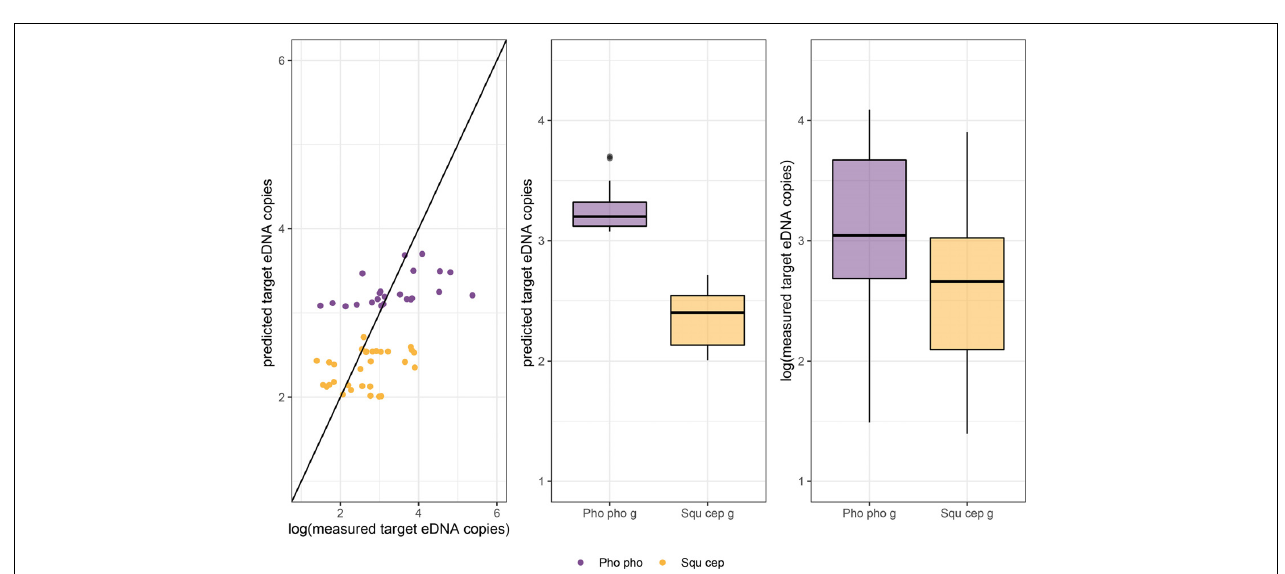
FIGURE 6 | For groups of Phoxinus phoxinus (Pho pho g) and Squalius cephalus (Squ cep g) measured and predicted copy numbers are plotted: left, against each other; middle, predicted copy numbers are compared between species; right, comparison of measured copy numbers between the two species. The measured copy numbers were log-transformed to enable a direct comparison with the values predicted by the Gamma GLMM with log-link function; the random effect of individual fish could not be taken into account for this prediction. For S. cephalus a significant difference between measured and predicted copy numbers was detected ( W = 609; p <